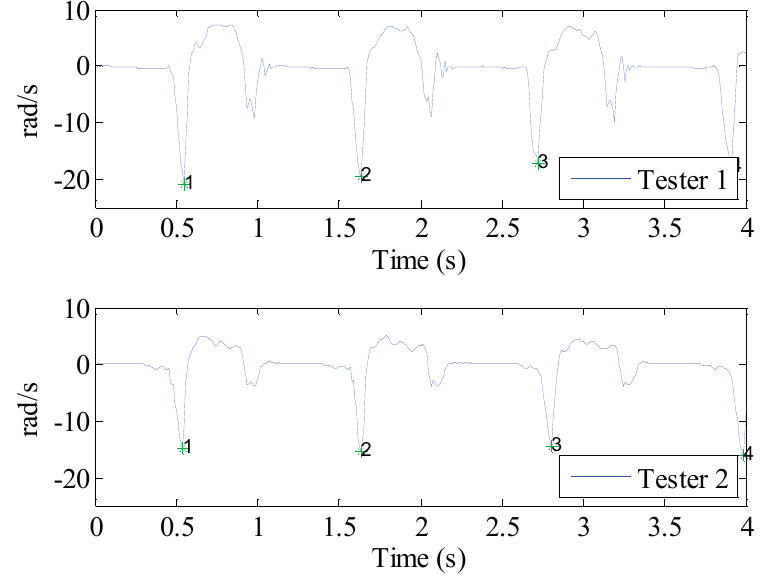
Figure 4. The y axis gyroscope measurements of two